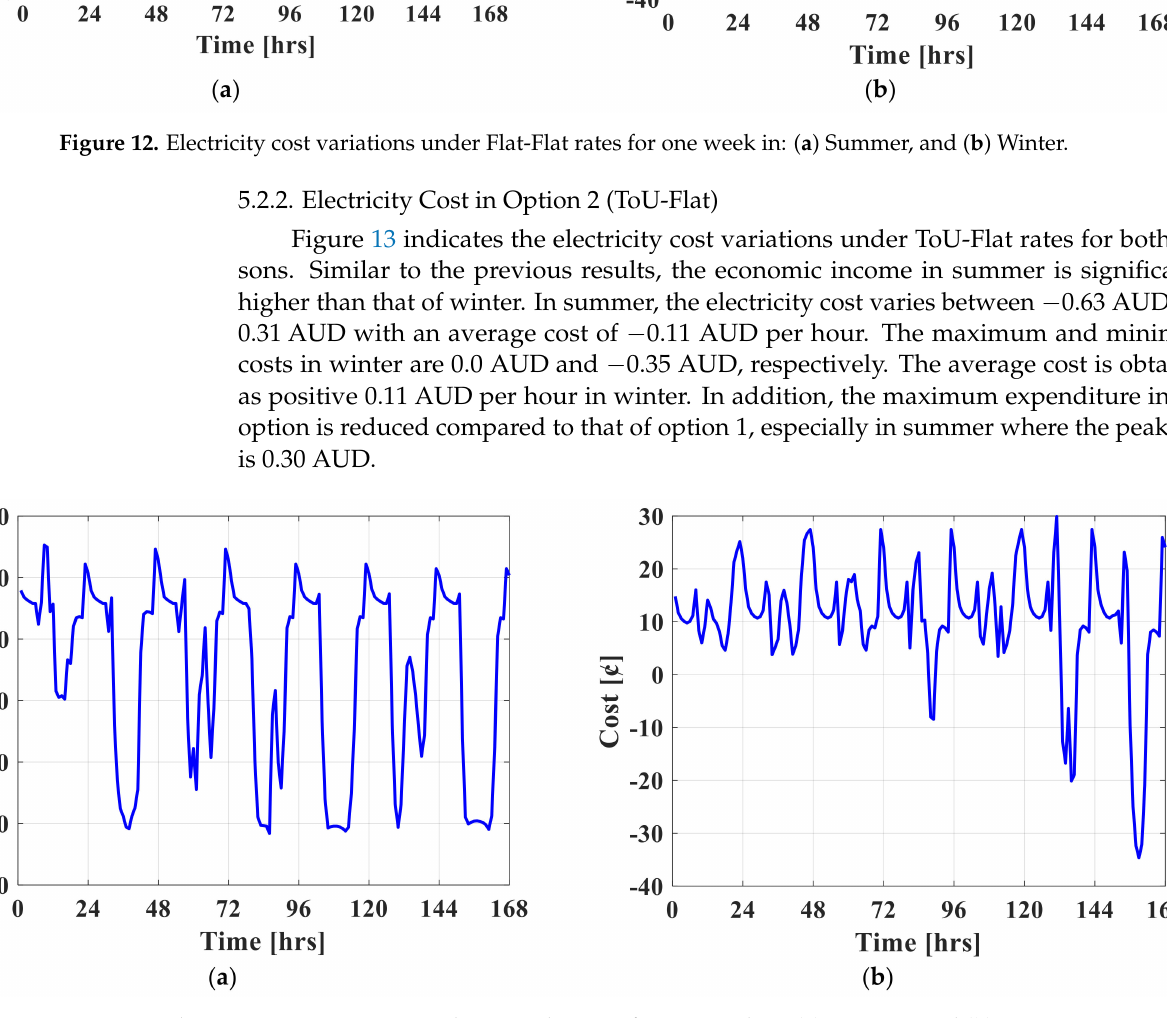
Figure 13. Electricity cost variations under ToU-Flat rates for one week in: ( a ) Summer, and ( b )